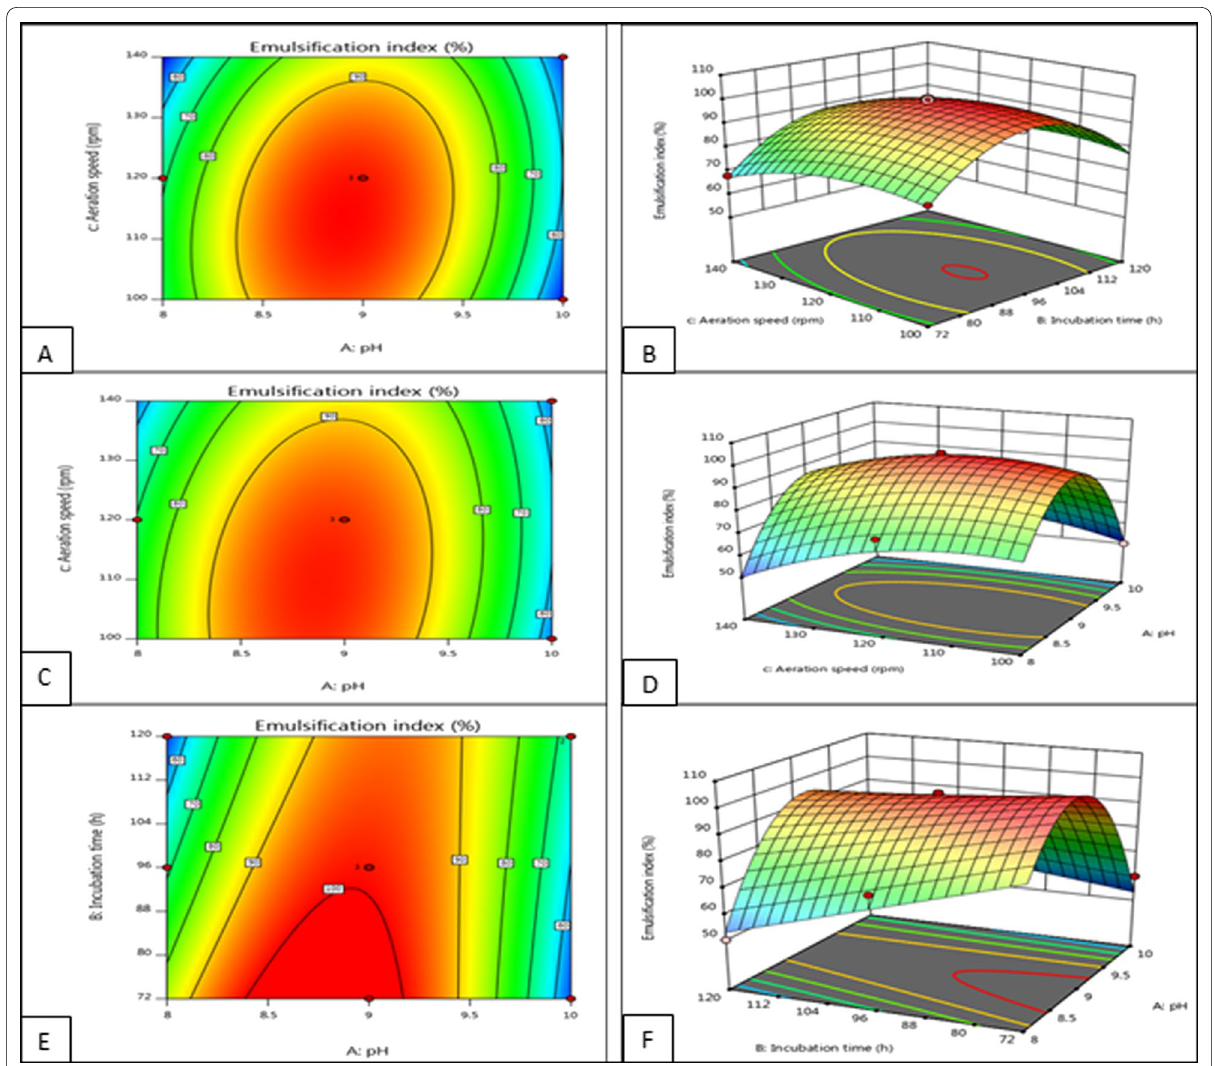
Fig. 4 A Contour curve the effect of aeration speed factors and incubation time kocuria rosea ABR6, B three‑dimensional (3D) curve of the effect of aeration velocity factors and incubation time, C contour curve the effect of pH and aeration rate factors kocuria rosea ABR6, D three‑dimensional (3D) curve of the effect of pH and aeration factors kocuria rosea ABR6, E contour curve the effect of pH factors and incubation time kocuria rosea ABR6, F three‑dimensional (3D) curve of the influence of pH factors and incubation time